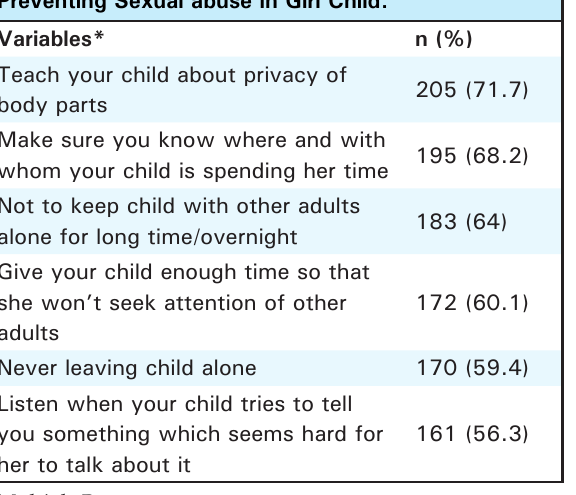
Table 2. Mother’s Awareness on Methods of Preventing Sexual abuse in Girl Child.